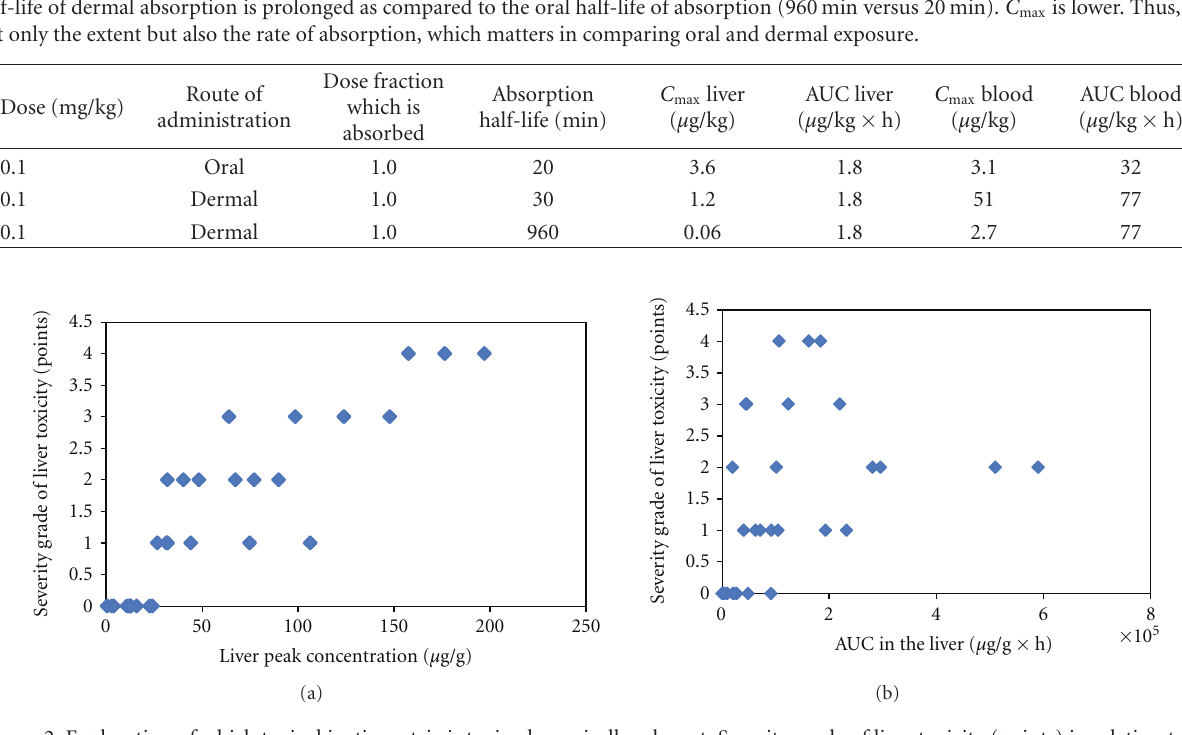
Figure 2: Exploration of which toxicokinetic metric is toxicodynamically relevant. Severity grade of liver toxicity (points) in relation to (a) the peak concentration in the liver ( μ g/g liver tissue) for coumarin in rat. (b) AUC in the liver ( μ g/g × h) for coumarin in rat. A toxicokinetic model has been constructed for the rat, and C max and AUC were simulated with doses and duration of exposure taken from published studies ( n = 11). The toxicological endpoint in the studies was liver toxicity the degree of which di ff ered, and we graded the toxicity in a scale from 0 to 4. C max in the liver (liver peak concentration) was better correlated to liver toxicity than AUC in the liver indicating that it C max in the liver is the toxicologically relevant toxicokinetic